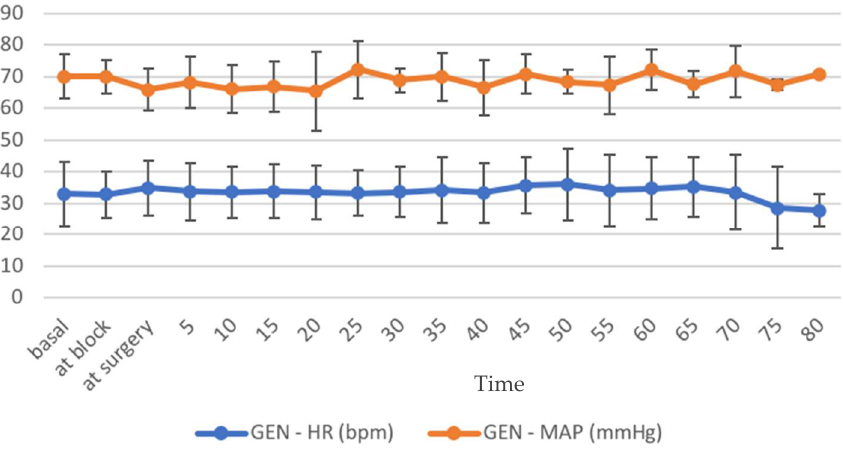
Figure 6. Heart rate (HR, beats/min) and mean arterial blood pressure (MAP, mmHg) recorded in horses included in group GEN (undergoing general anesthesia, n = 9) during surgery. Data are reported as mean value and bars represent standard deviation.